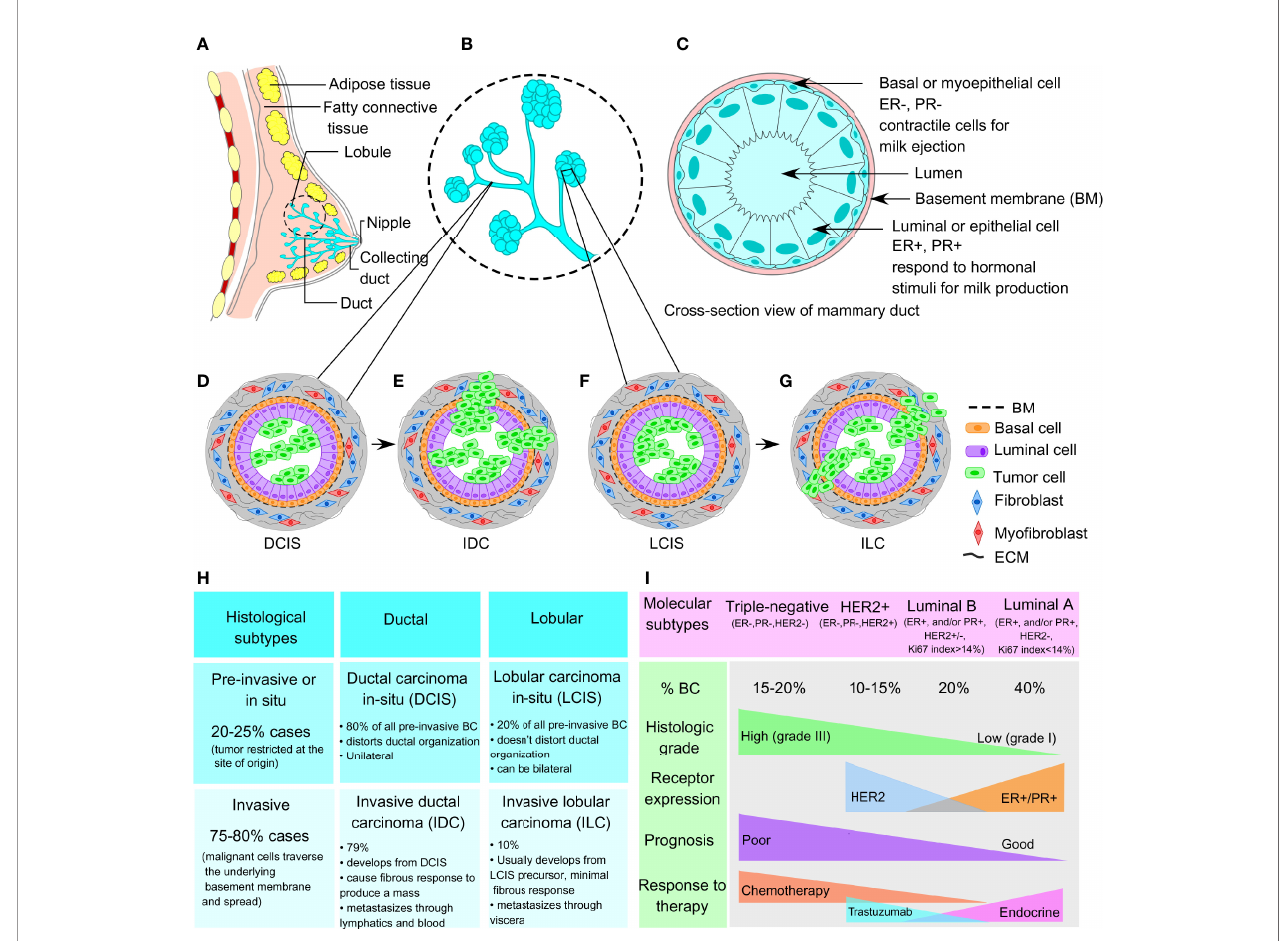
FIGURE 1 | Normal breast architecture and breast cancer subtypes. (A) Representative image of breast architecture showing lobular and ductal system. (B) Magni fi ed view of milk duct showing detailed lobular and ductal structure as an inset image. (C) Cross-sectional view of normal mammary duct showing basement membrane, basal myoepithelial cell layer, and luminal or epithelial cell layer from outside to inside. (D) Representative images of ductal carcinoma in situ (DCIS) and (E) invasive ductal carcinoma (IDC). (F) Representative images of lobular carcinoma in situ (LCIS) and (G) invasive lobular carcinoma (ILC). (H) Histological subtypes (preinvasive and invasive) and (I) molecular subtypes (triple-negative, HER2+, luminal A, and luminal B) of breast